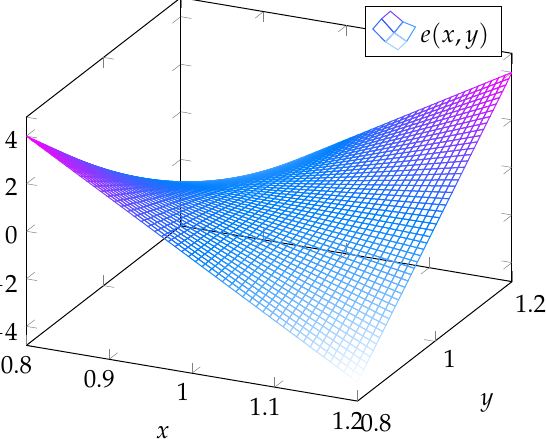
Figure 2. Percentage of error between the exact and the linear approximation function for the product of two